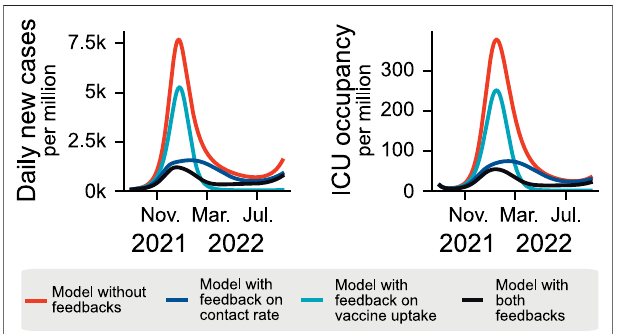
FIGURE 3 | Incorporating behavioral feedback loops in compartmental models broadens the dynamic range of the solutions and yields more realistic results. Different variations of a compartmental model are displayed to show the effect of the two feedback loops used in our model: When ICU occupancyincreases,individualsincreasetheirhealth-protectivebehaviorand aremorewillingtobevaccinated.Thisdynamicaladaptationcanbreakawave at lower case numbers and lead to extended infection plateaus (blue curves), which a classic compartment model is unable to reproduce as it does not incorporate the population ’ s reaction to the disease (red